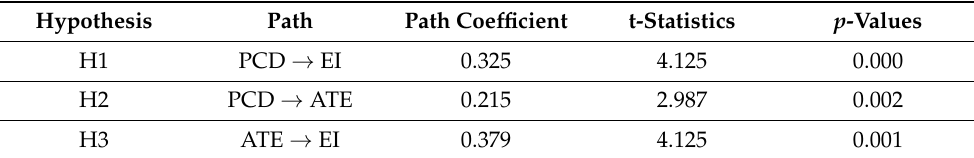
Table 3. Direct effect.